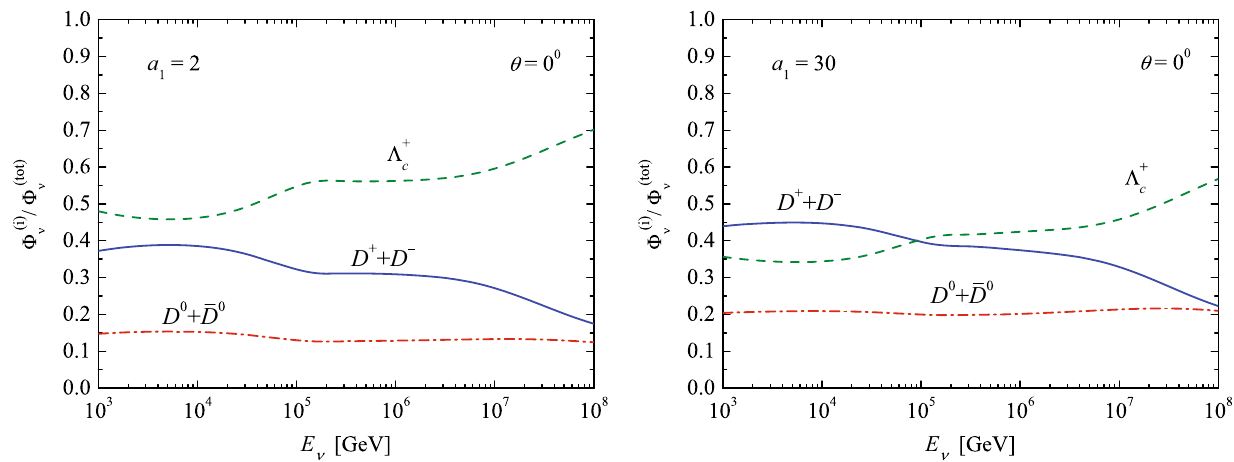
Fig. 14 Partial contributions to the prompt muon neutrino flux calculated with QGSM for NSU spectrum with α ψ ( 0 ) = − 2 . 2 for a 1 = 2 (left) and a 1 = 30 (right)